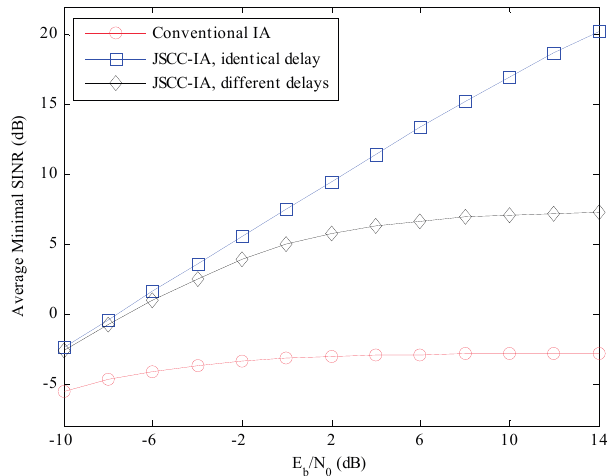
Figure 8. The average minimal received SINR of the conventional IA scheme and the JSCC-IA schemes with identical/different propagation delays in the (6 × 6, 2) 18 symmetric